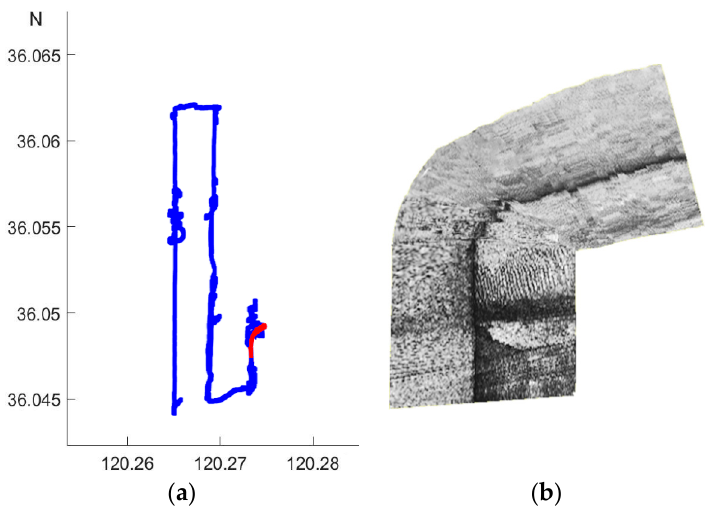
Figure 7. AUV path and SSS mosaicking. ( a ) AUV path. ( b ) SSS mosaicking. At the beginning, we utilized the manually labeled sand wave annotation in historic surveys by research vessel with the high resolution SSS on board for the standard references. During the process of SSS imaging acquisition by AUV, we further accumulated and refined the sand wave annotation as our ground truth. Figure 8 shows the example SSS imaging collected and the corresponding labeling, with sand waves in yellow and non sand waves in blue, respectively.